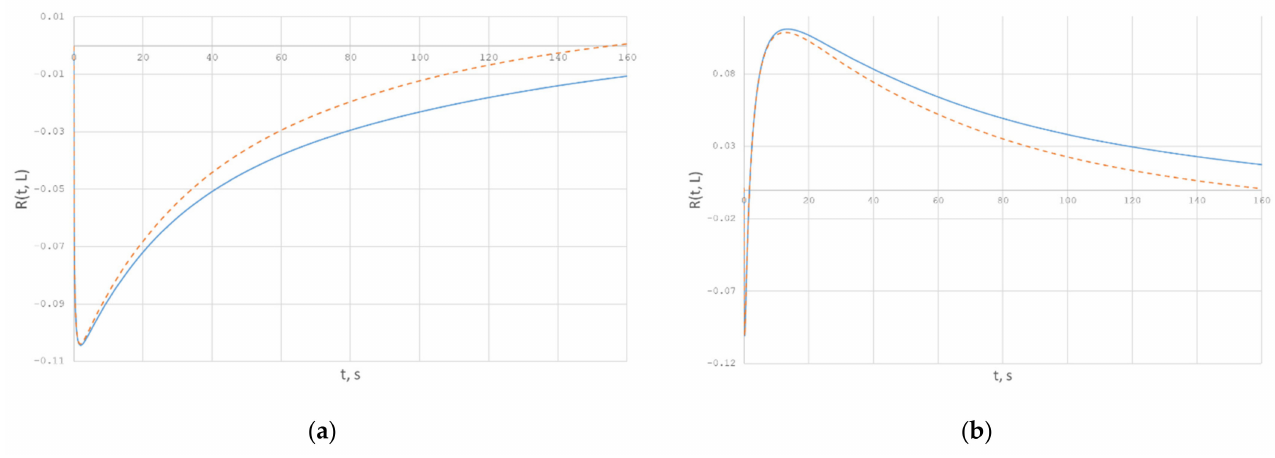
Figure 24. ( a , b ) Comparison of the deviation functions of the resulted fiber radii for two different drawing